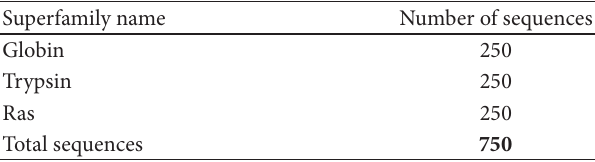
Table 5: Details of dataset 2 used in the experiments.